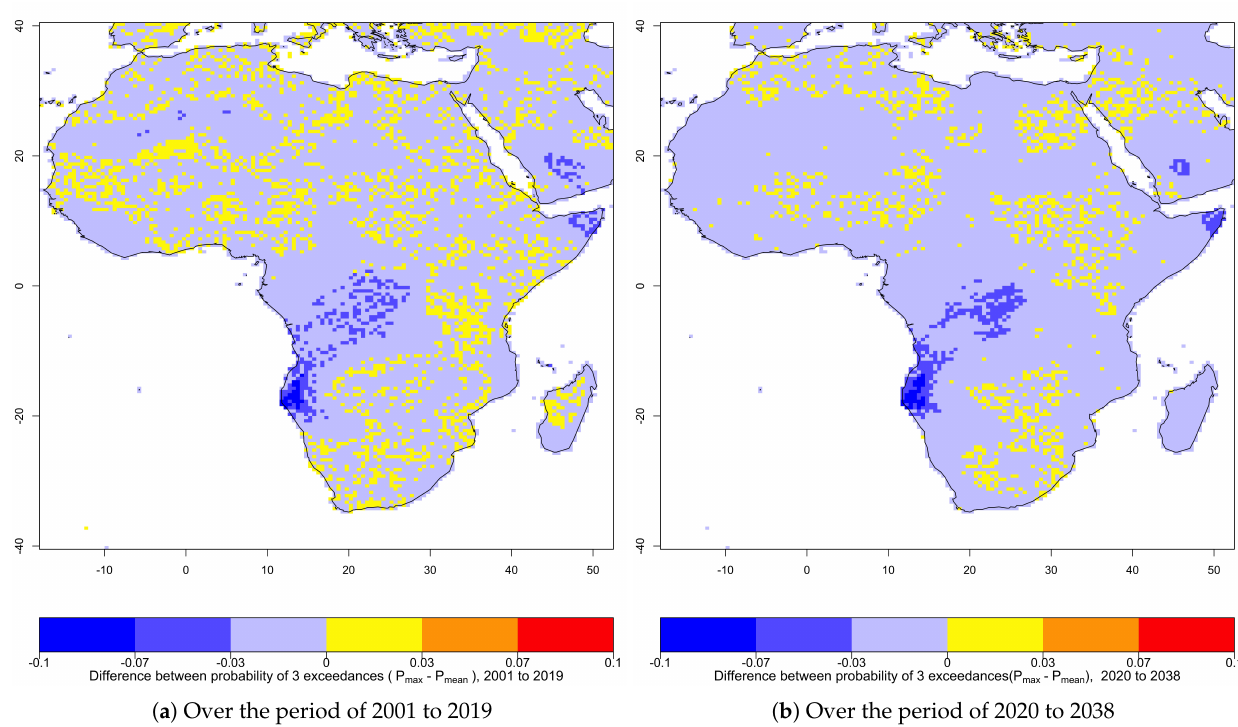
Figure 13. Difference between probability of 3 exceedances of extremes in annual maxima and annual means ( P maxima P means ) within each 19 year period: ( a ) over the period of 2001 to 2019 & ( b ) over the period of 2020 to 2038. −